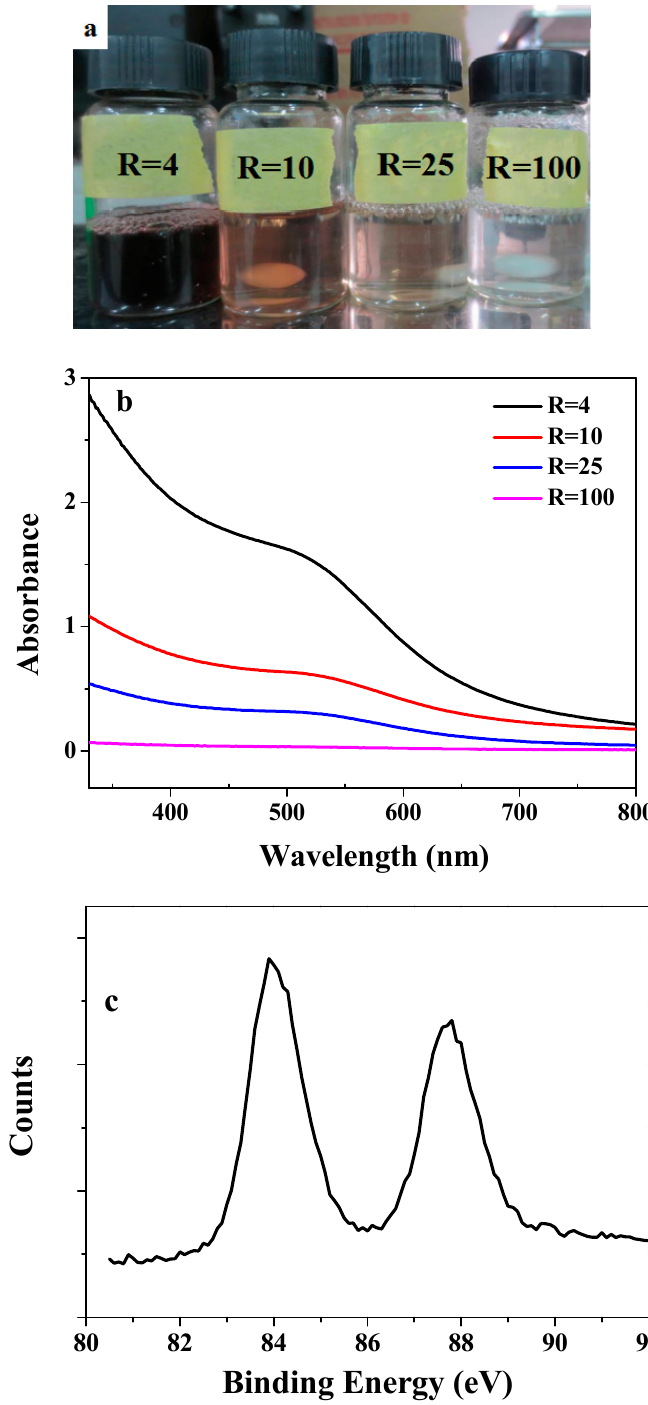
Figure 1. ( a ) Photographs of a mixed aqueous micellar solution of HAuCl 4 by the addition of a fresh aqueous solution of NaBH 4 in the above mixture after 24 h. ( b ) UV-visible absorption spectra of micelles with different Au concentrations. ( c ) XPS spectrum of micelles with gold nanoparticles (AuNPs) at R = 10 (R is the molar ratio of 4VP to Au).